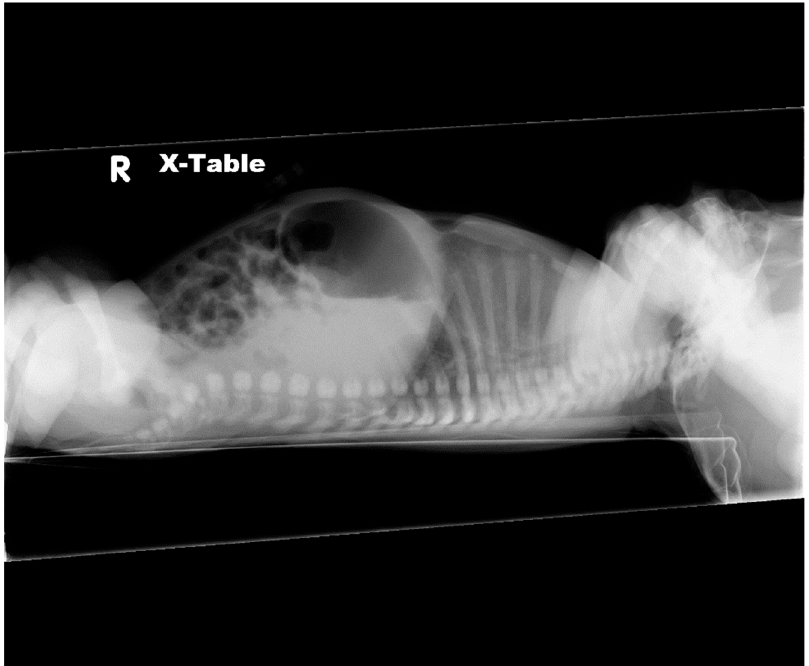
Figure 4. Lateral radiograph showing agenesis of lower third of sternum.